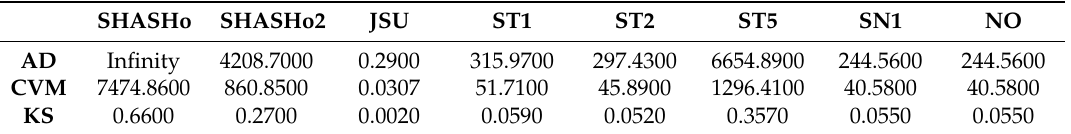
Table 2. Goodness-of-fit statistics for selected distributions.